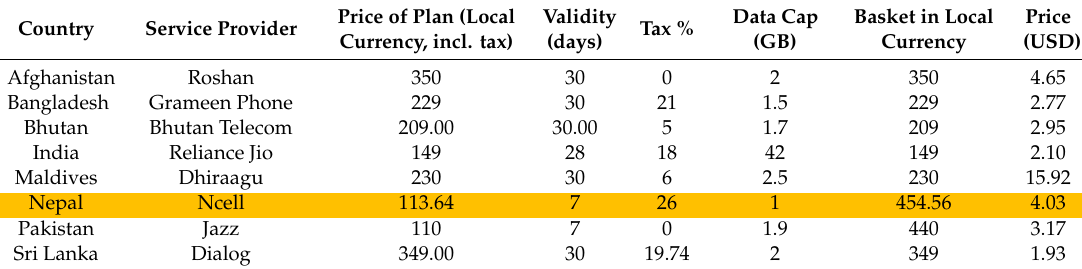
Table 2. Mobile broadband prices in South Asian countries [11].